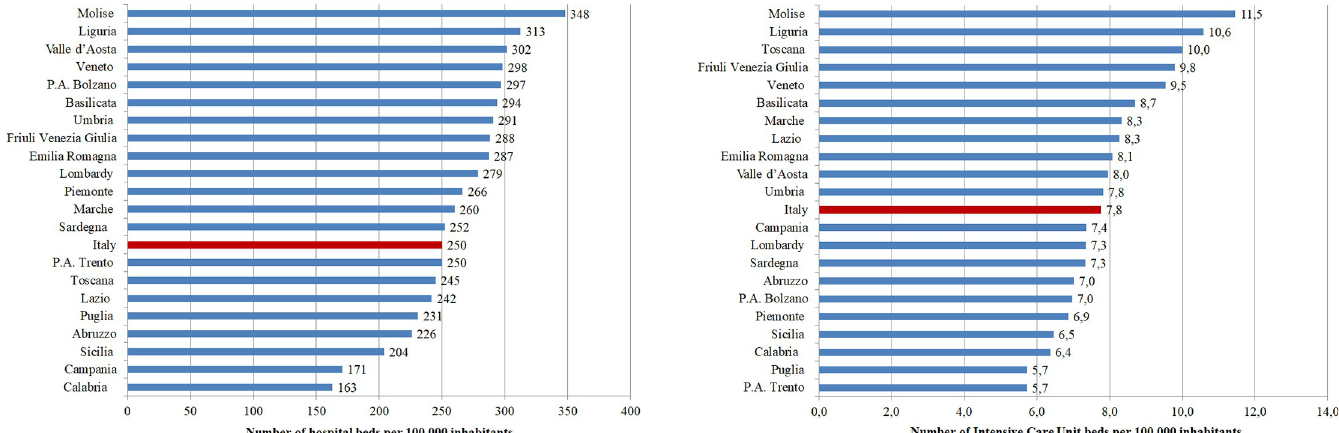
Fig 3. Number of total and intensive care unit beds per 100000 inhabitants in the different Italian regions.